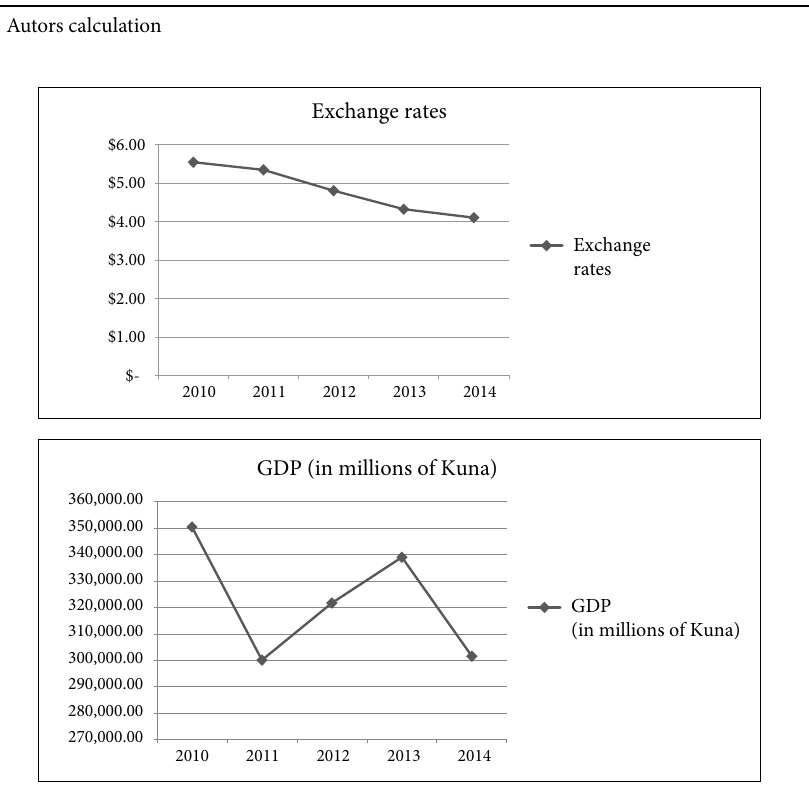
Fig. 1. Dollar exchange rate depreciation scenario impact on GDp. Source: autors